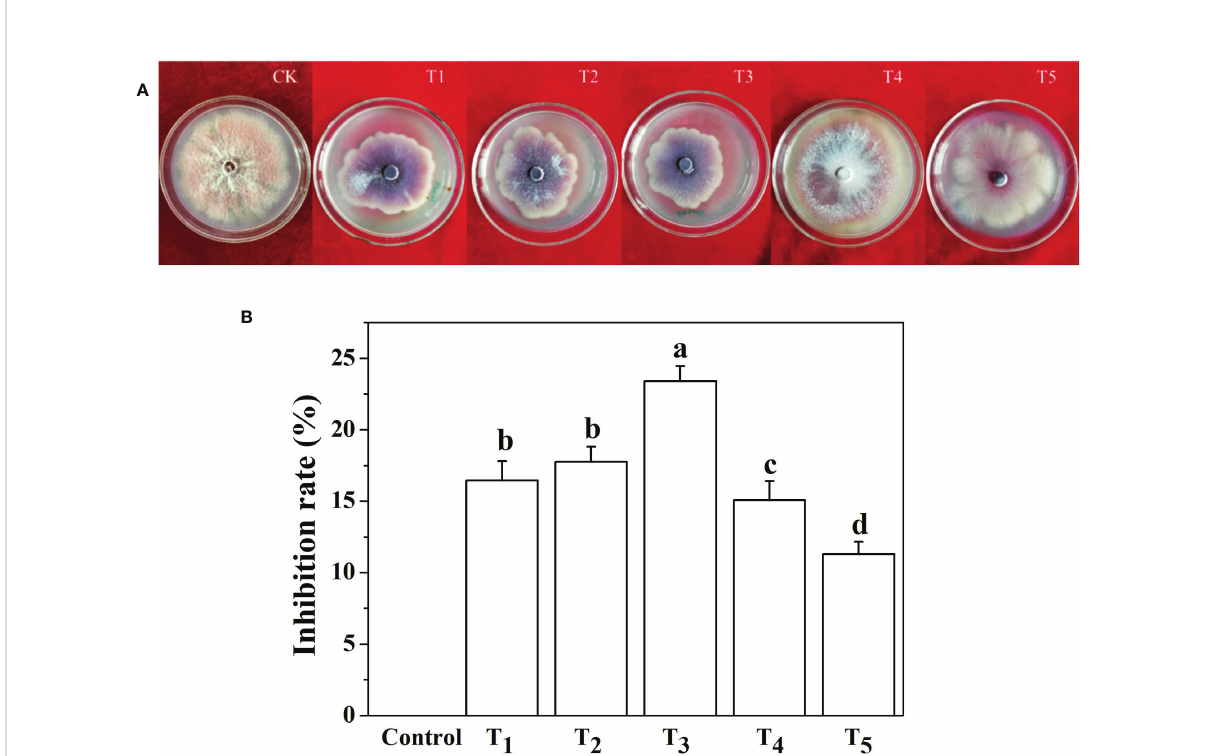
FIGURE 1 Screening of optimal silicon (Si) concentrations against Fusarium oxysporum (f) sp. cucumerinum fungi. (A) Photographs of in vitro culture of Fusarium fungi in fi ve different silicon concentrations on PDA plates for 7 days. (B) Inhibition rate of fi ve silicon concentrations on mycelial growth of Fusarium when cultured for 7 days. CK or control, 0 mmol·l -1 Si; T 1 , 1 mmol·l -1 Si; T 2 , 2 mmol·l -1 Si; T 3 , 3 mmol·l -1 Si; T 4 , 4 mmol·l -1 Si; and T 5 , 5 mmol·l -1 Si. Means denoted by the different lowercase letters indicate a signi fi cant difference according to Tukey ’ s test ( P ≤